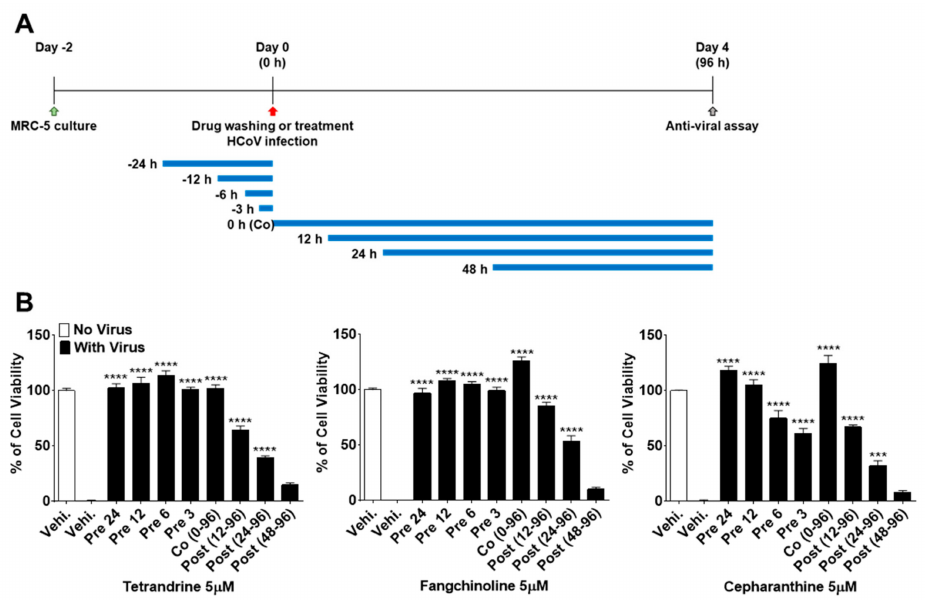
Figure 4. Time course assay of TET, FAN, and CEP. MRC-5 cells were treated with 5 µ M compounds (Vehicle 0.025% DMSO) for 24 h (pre 24), 12 h (pre 12), 6 h (pre 6), and 3 h (pre 3) prior to HCoV-OC43 infection or during infection (co 0–96), at 12 h (post 12–96), 24 h (post 24–96), and 48 h (post 48–96) post-infection. ( A ) The overall scheme for time-of-additional assay. The blue lines refer to the compound administration period. ( B ) The cell viability was assessed by MTS-based assay at four dpi. Data are presented as means ± SEM and are representative of three independent experiments. *** p < 0.001, **** p < 0.0001 (One-way ANOVA plus Tukey’s multiple comparisons test) compared